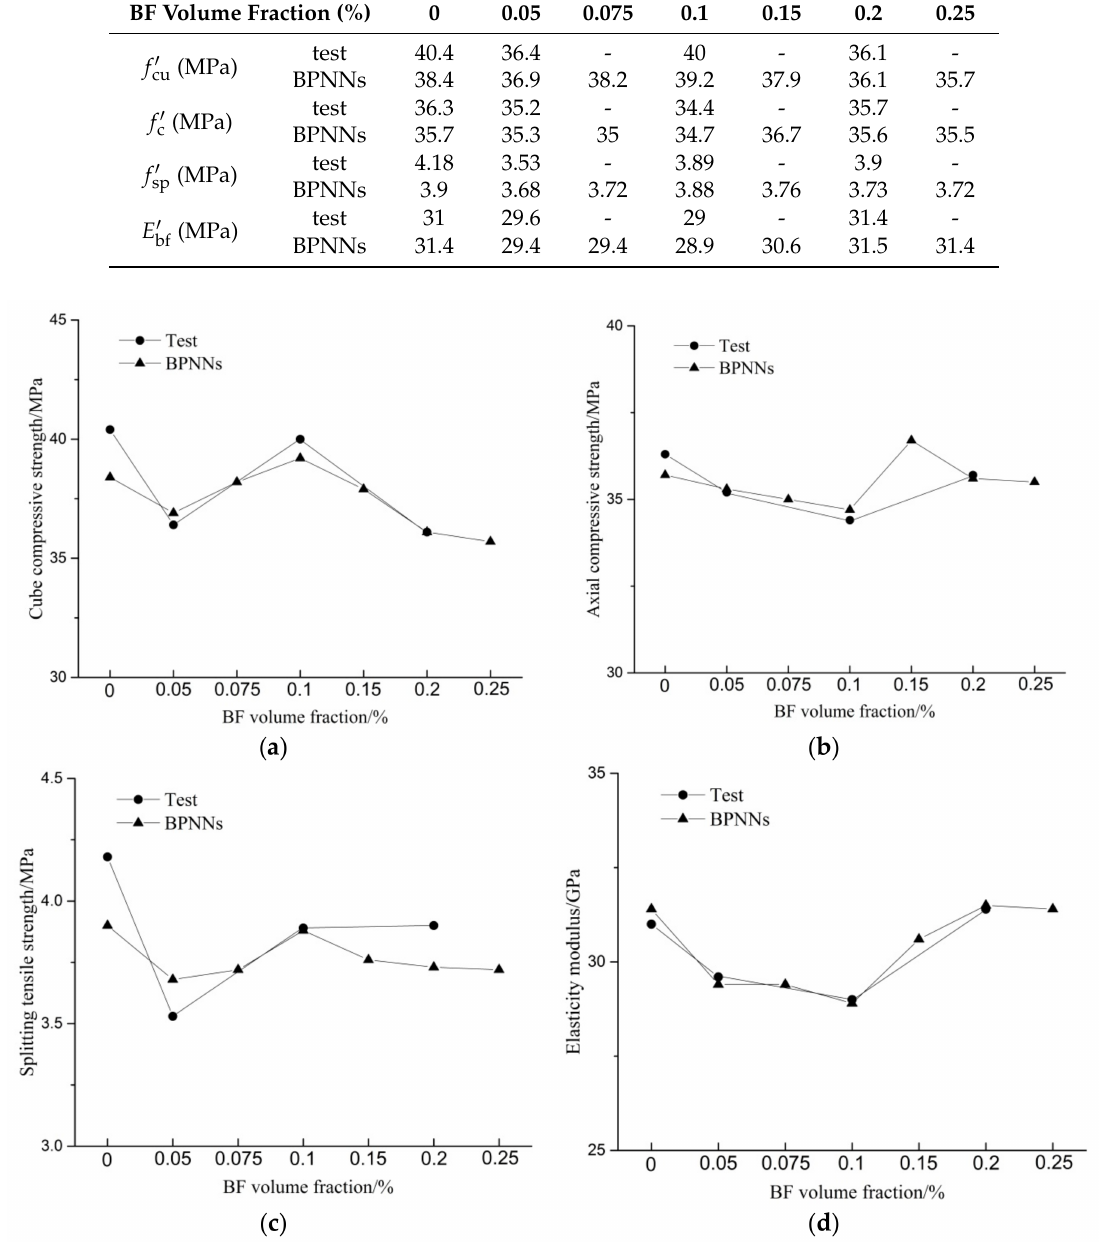
Figure 10. Comparison between BPNNs predictions and test results. ( a ) Cube compressive strengths; ( b ) Axial compressive strengths; ( c ) Splitting tensile strengths; ( d ) Elasticity